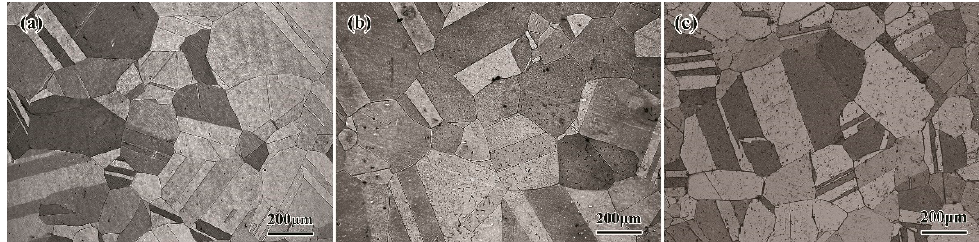
Figure 1. Optical microscope (OM) images showing the original microstructures of Cu–Ni alloys containing 5 at.% Ni ( a ), 10 at.% Ni ( b ), and 20 at.% Ni ( c ).